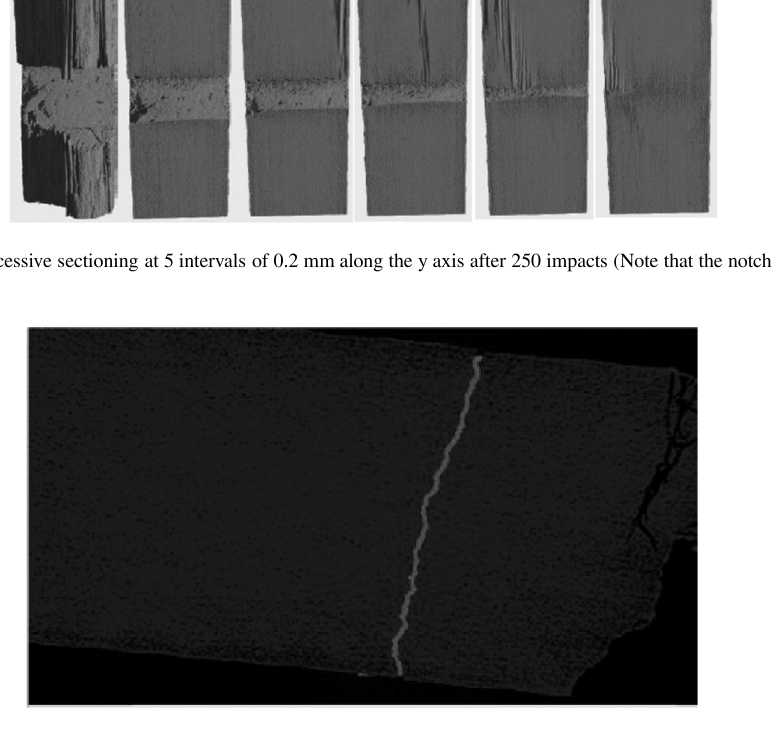
Fig. 13. Specimen top view highlighting the capabilities of the region growing algorithm to isolate the crack